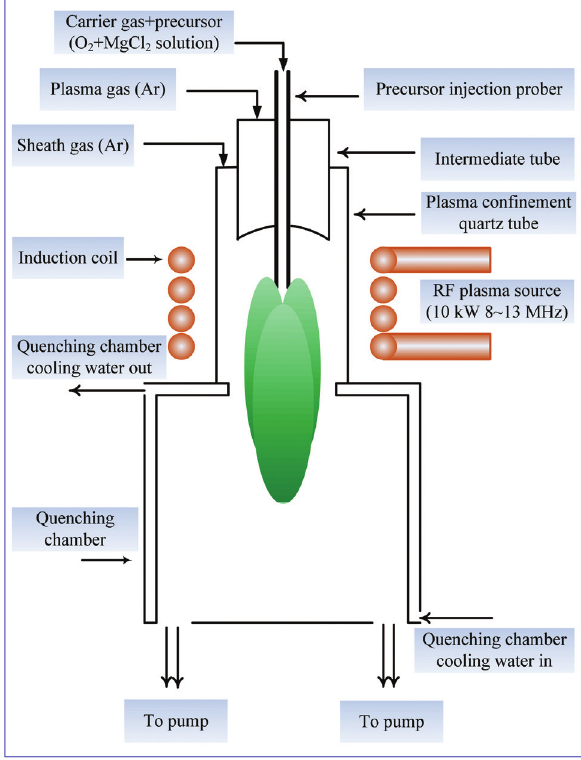
Figure 1 Schematic diagram of the radio frequency (RF) induction thermal plasma